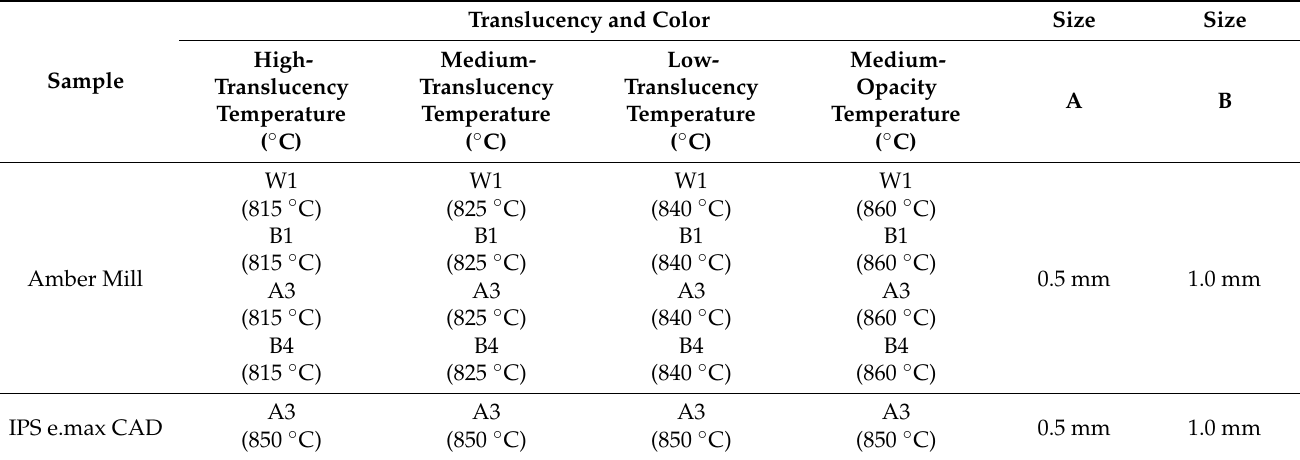
Table 1. Description of the dental glass-ceramics systems used in the study (brand, color, transparency, sintering temperature, and